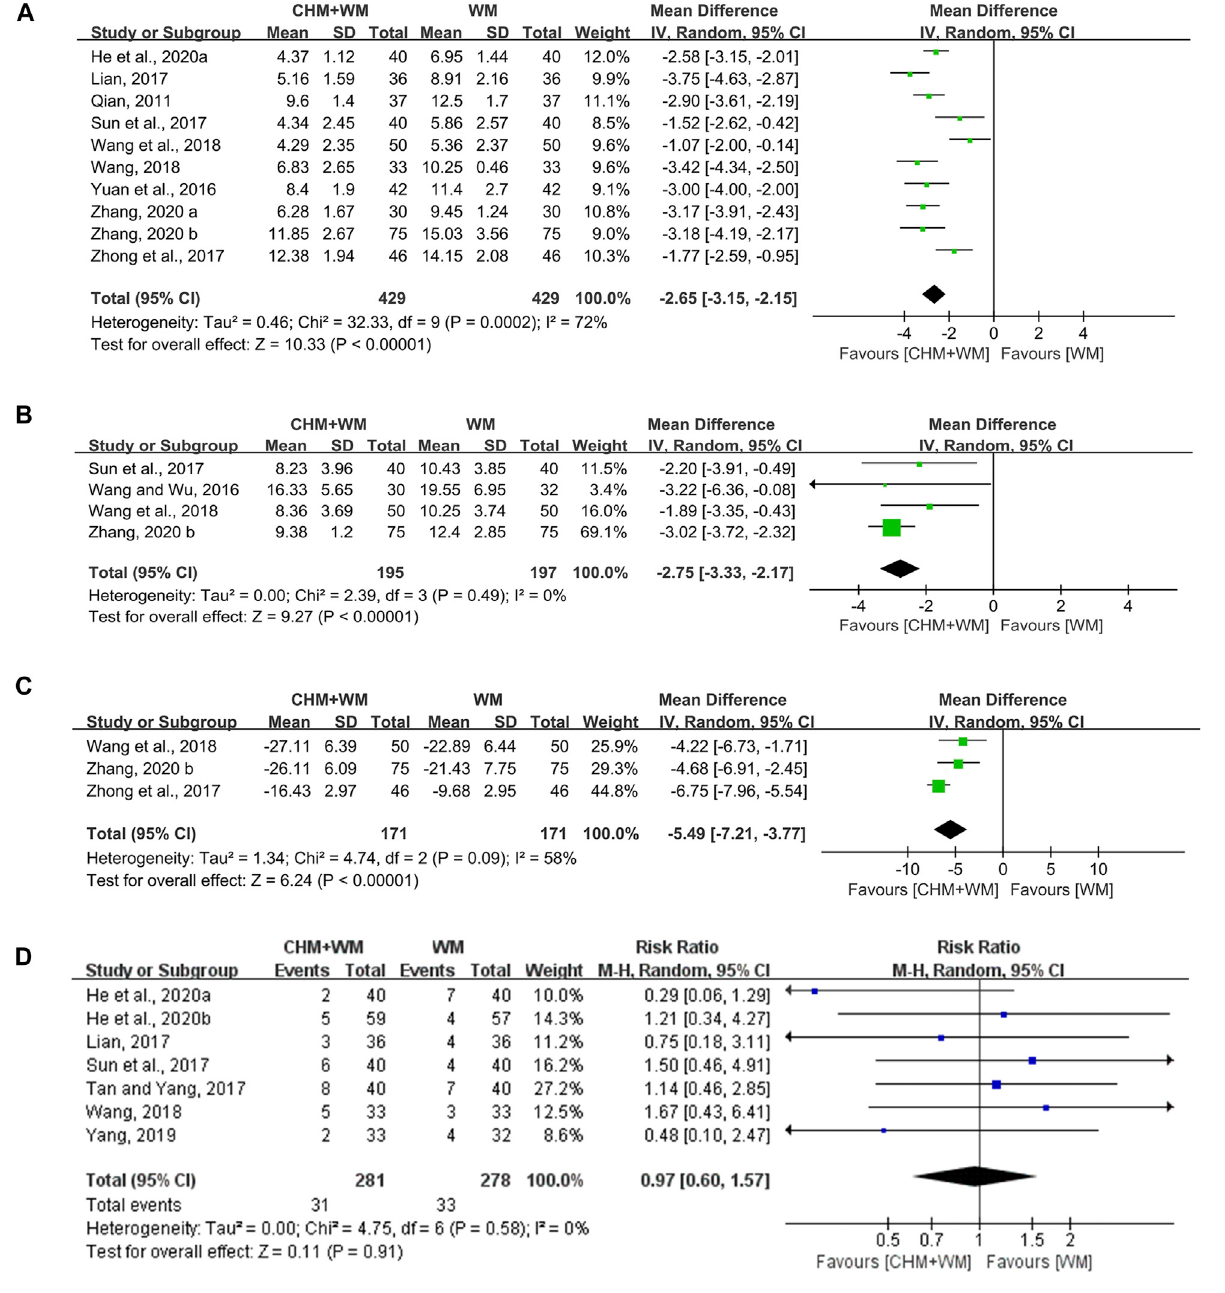
Frontiers in Pharmacology |